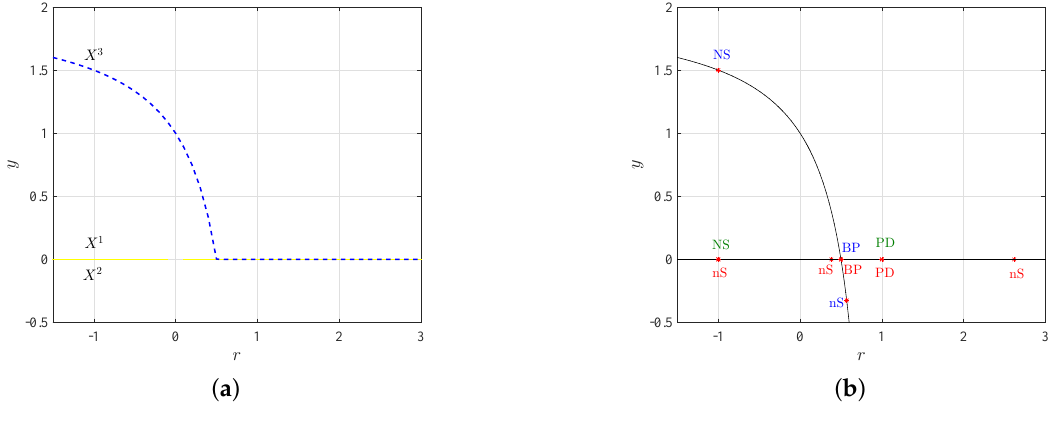
Figure 1. The bifurcation diagram for the system in Equation (7) in ( r , y ) -plane: ( a ) the nested system in Equation (7) is repeated 10 5 times for different r and using the fixed points as initial point; and ( b ) the nested system in Equation (7) is repeated 10 5 times for different r and using continuation method (i.e., MatContM). The bifurcation points labeled in green correspond to the fixed point curve computed along X 1 , the red points correspond to the fixed point curve along X 2 , while the blue ones correspond to the fixed point curve along X 3 .